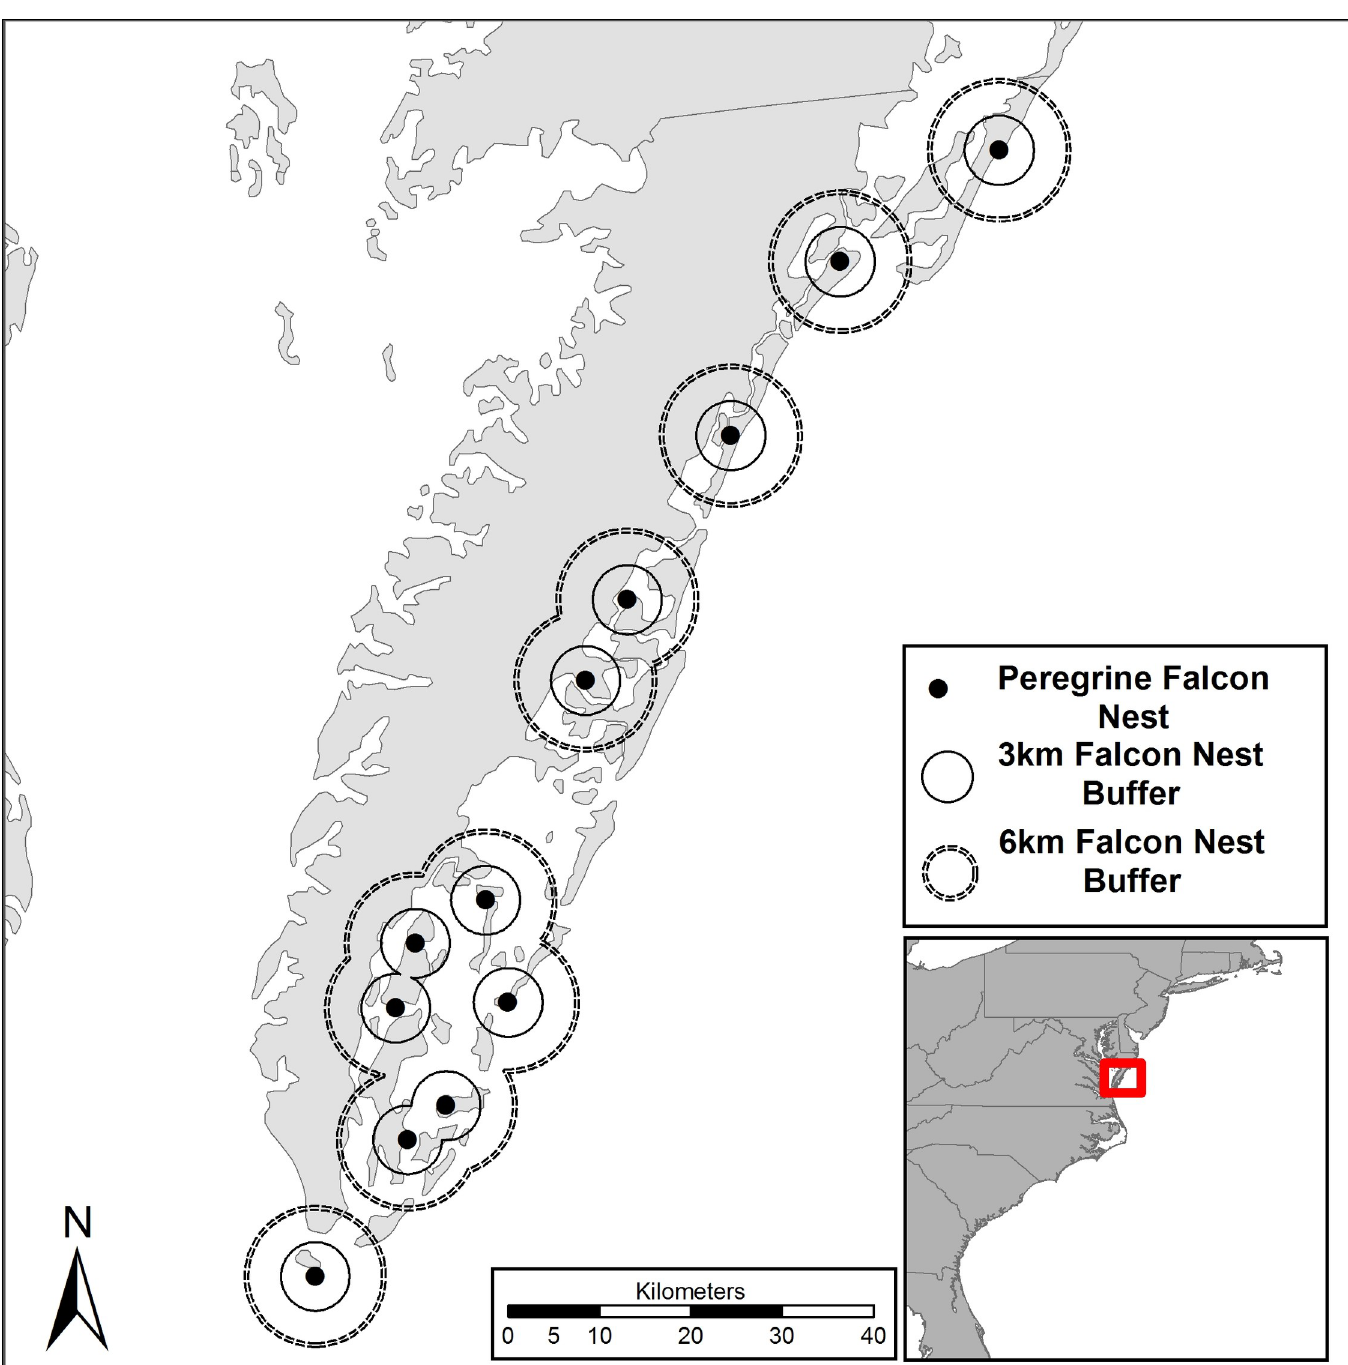
Fig 1. Map of study area with peregrine falcon eyries and buffer boundaries used to delineate beaches within different proximity categories. Red knot surveys were flown along barrier island beaches that lie along the Atlantic Ocean. Base map layer is credited to the National Atlas of the United States of America.